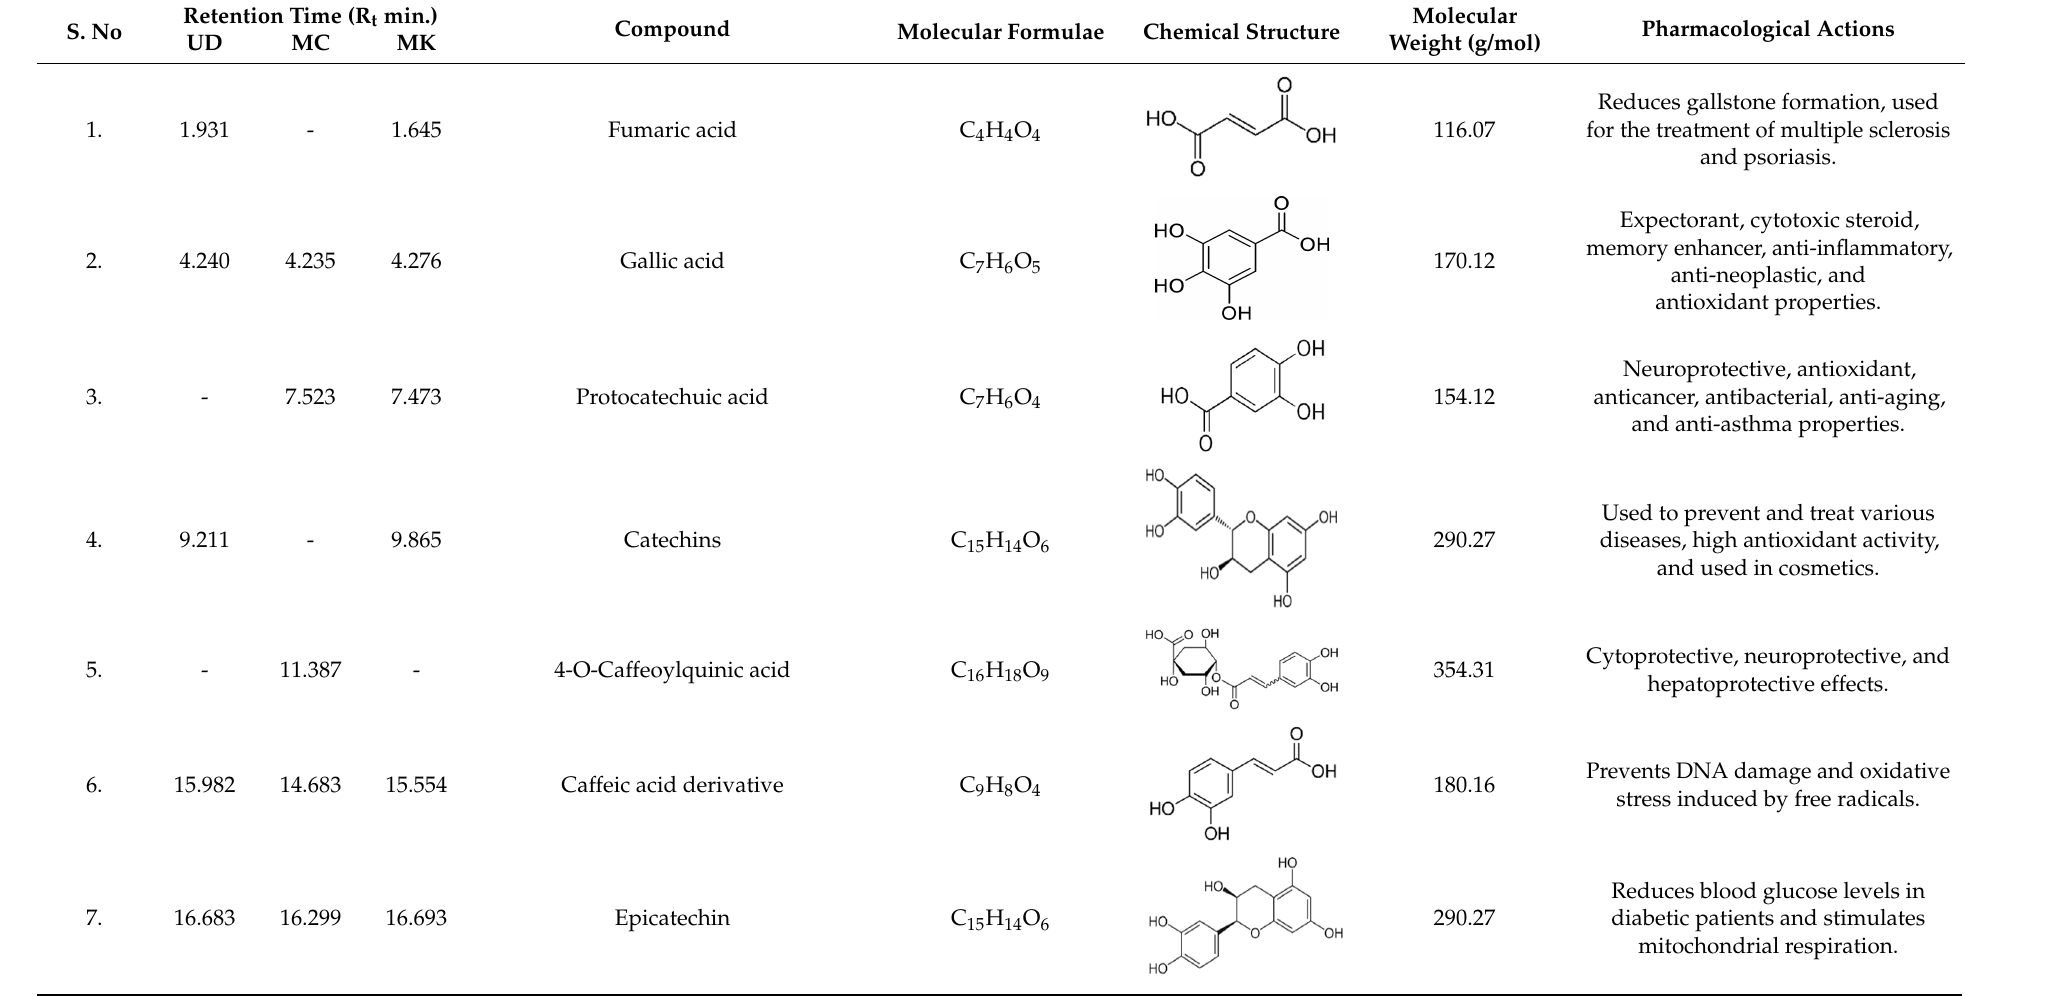
Table 6. Major phytochemical compounds identified in ethanolic extracts of U. dioica, M. chamomilla , and M. koenigii . Retention Time (R t min.) S. No